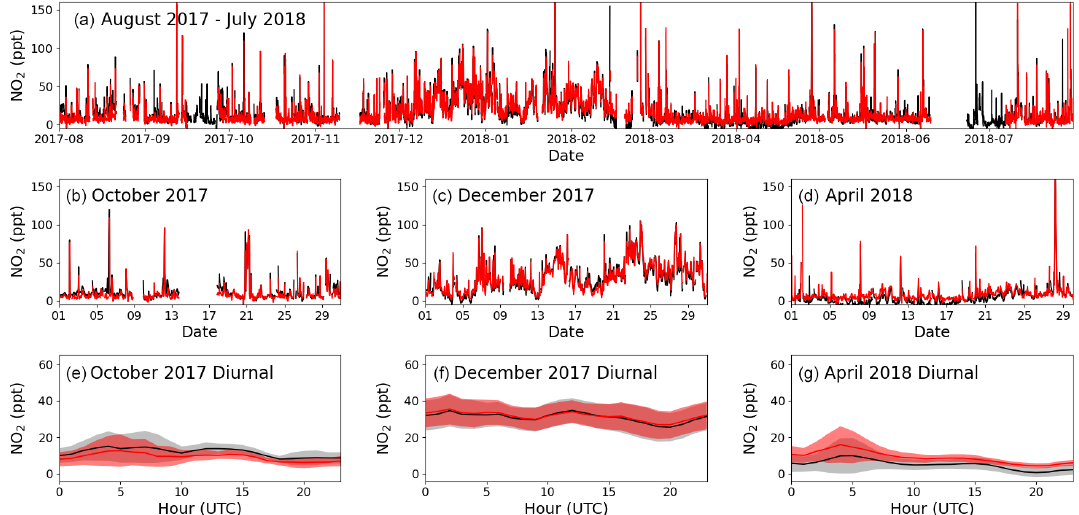
Figure 6. Panel (a) shows the time series of filtered O 3 -corrected NO 2 from 1 August 2017 to 31 July 2018 for the BLC (black) and PLC (red). Panels (b) , (c) , and (d) zoom in on October 2017, December 2017, and April 2018, respectively, with the red line being the PLC and the black line the BLC. Panels (e) , (f) , and (g) show the average diurnal of NO 2 for October 2017, December 2017, and April 2018, respectively, with the red line being the PLC, the black line being the BLC, and the coloured areas being ± 2 standard errors. If there are fewer than 15 measurements available for the hour, it is not included in the diurnal.